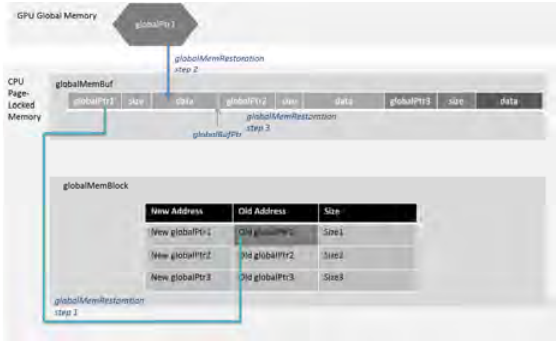
Fig. 12. Process Layout of Global Memory Restoration